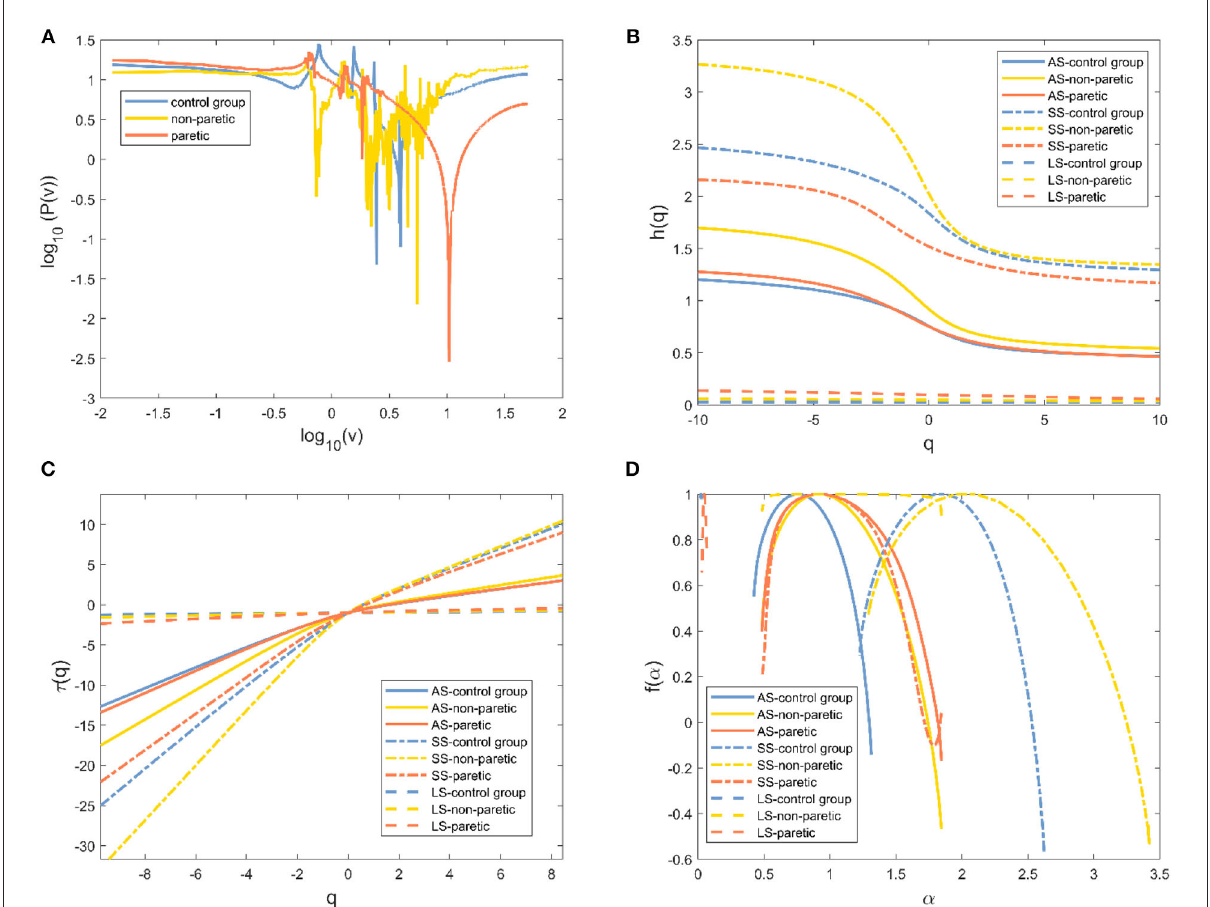
FIGURE3 Evidence of multifractality in the knee angle time series for one of three different cases. (A) Fourier power spectrum of the knee angle time series. (B) Generalized Hurst exponent h(q) vs. order q . (C) Classical scaling exponent τ ( q ) vs. order q . (D) The resulting singularity spectrum f ( α ) . Healthy subjects (blue line), non-paretic limbs (yellow line), and paretic limbs (red line) of a patient after stroke (AS: all-scale, —; SS: short-scale, – -; LS: long-scale, –